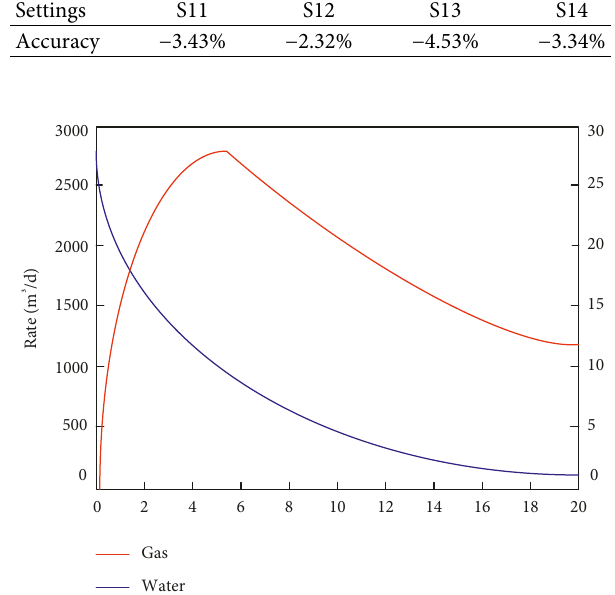
Table 1: Performance decrement ( algorithms on our adopted data set.